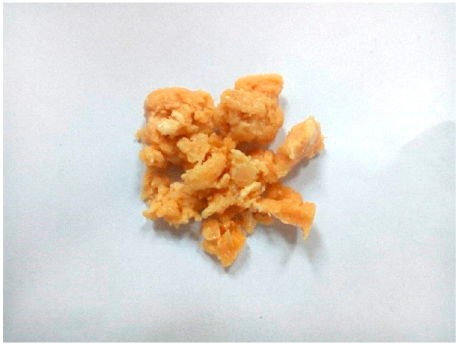
Figure 1. Imidazoline inhibitor .